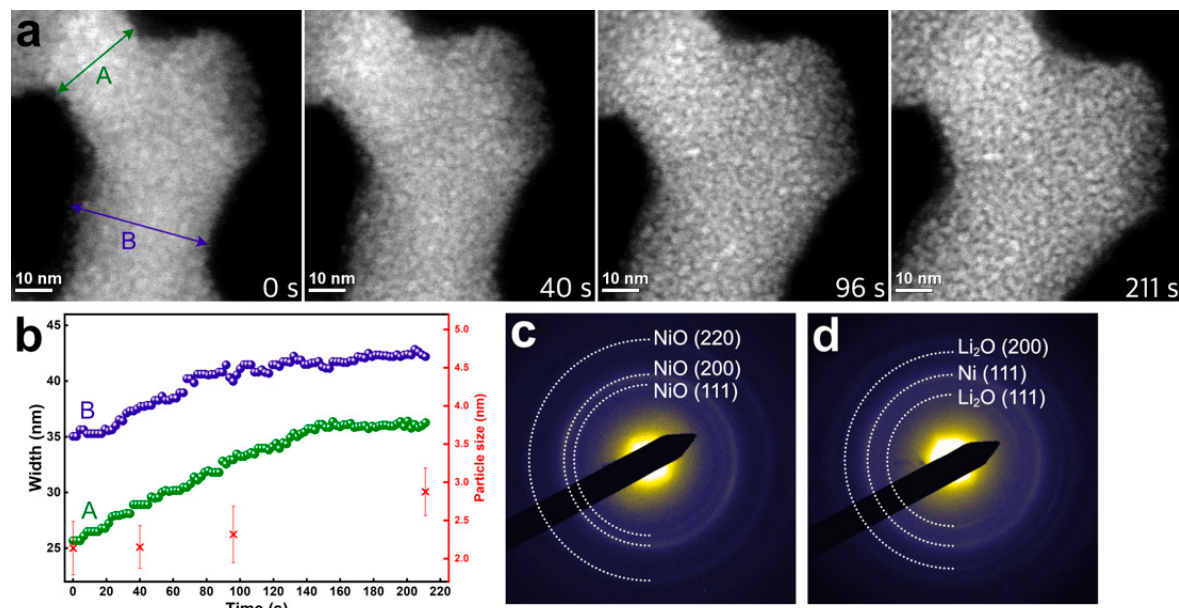
Figure 2. ( a ) Time-series HAADF-STEM images of pre-cycled NiO during lithiation. ( b ) The changes in the width of A and B in ( a ) and size of inside particles with lithiation. Selected area electron diffraction (SAED) patterns of ( c ) before and ( d ) after in situ lithium insertion.